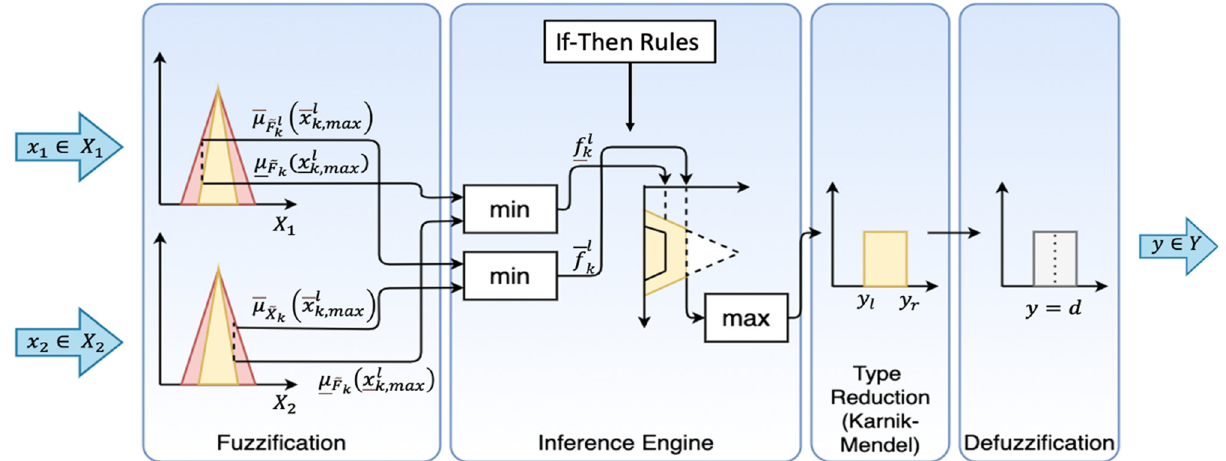
Figure 1. Type-2 Fuzzy Logic Algorithm and Study Design. General overview and different features of the Type-2 Fuzzy system including fuzzification, rules, inference engine, type reduction, and defuzzification. The T2 FS structure includes the min and max operations as fuzzification and inference engine process.